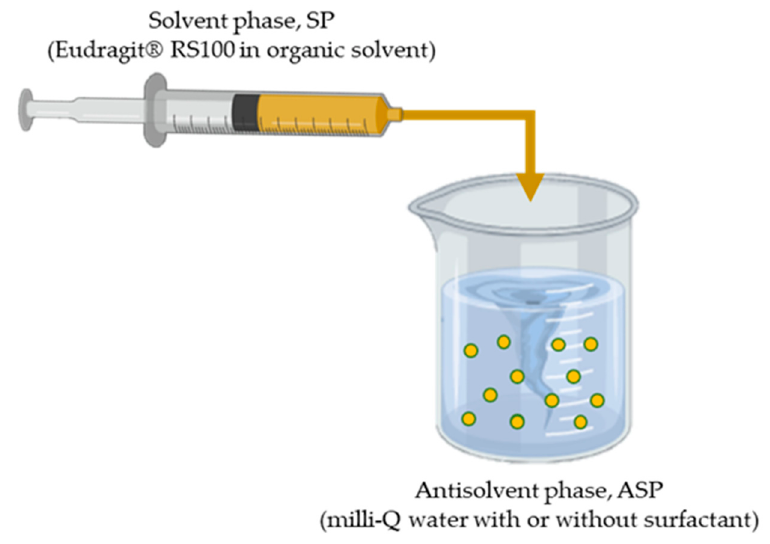
Figure 1. Schematic representation of the conventional batch nanoprecipitation method.